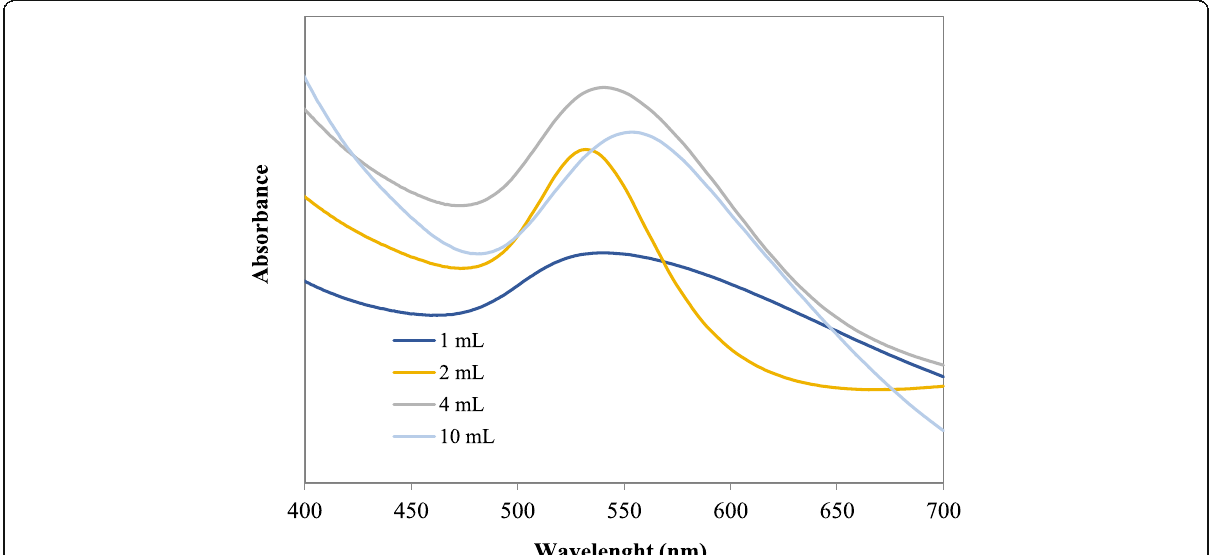
Fig. 1 UV-Vis spectra of the synthesized AuNPs using different amount of jujube extract after 2